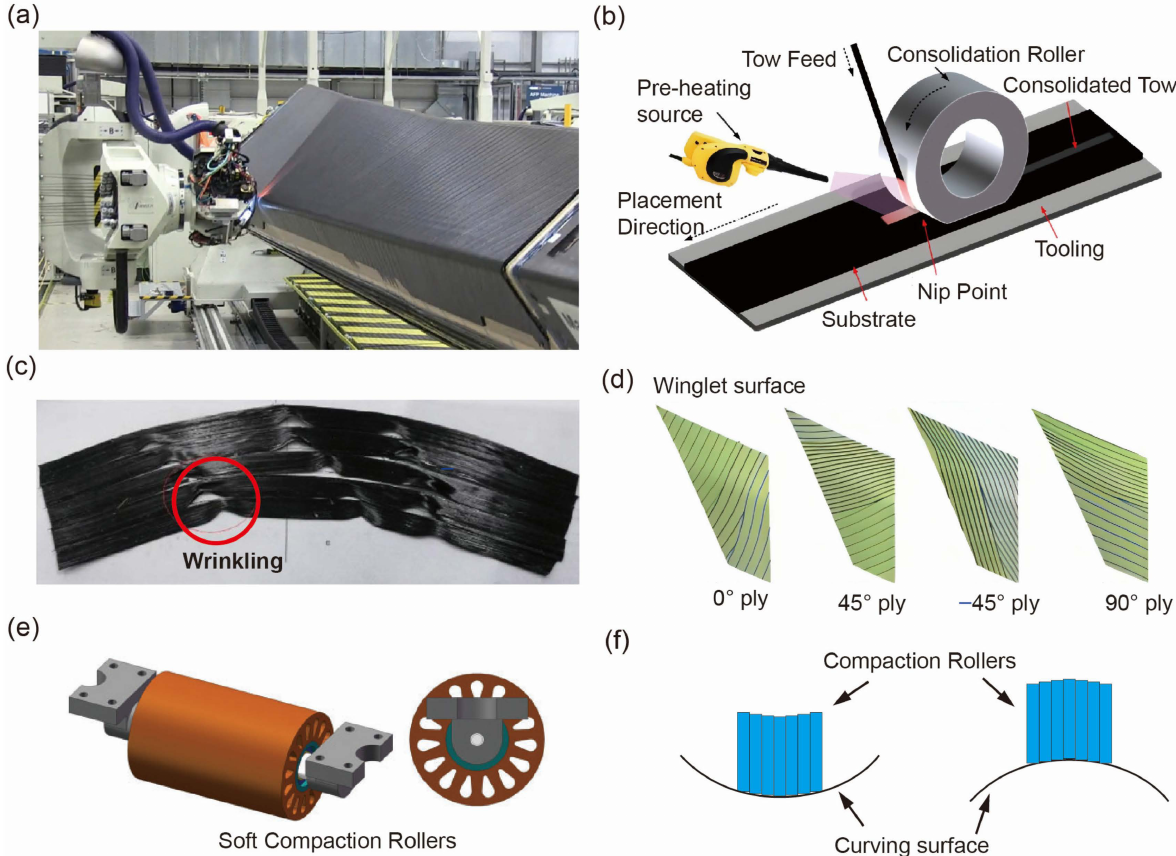
Figure 10. Automated layup technology. ( a ) AFP machine placing 64 fiber tows simultaneously [126]; ( b ) AFP process with in situ consolidation (Reprinted with permission from Ref. [127]. 2017, Elsevier); ( c ) Tow wrinkling at curving path (Reprinted with permission from Ref. [128]. 2020, Elsevier); ( d ) Pavement path planning along different direction of the winglet surface [129]; ( e ) Soft compaction roller (Reprinted with permission from Ref. [130]. 2019, SAGE); and ( f ) Segmented compaction rollers consisting of multiple small rollers (Open Access, Ref. [13], 2021,